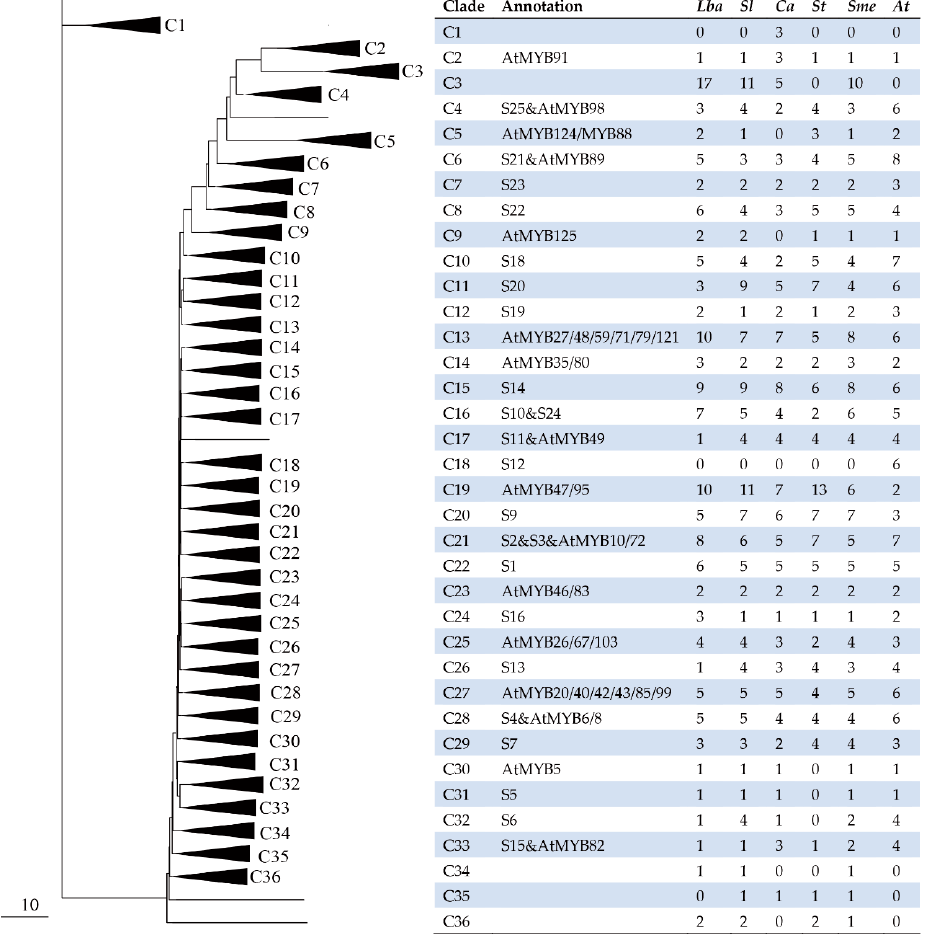
Figure 2. A phylogenetic tree of R2R3-MYB proteins. A total of 137 proteins from wolfberry ( Lba ), 133 from tomato ( Sl ), 108 from pepper ( Ca ), 109 from potato ( St ), 123 from eggplant ( Sme ), and 124 from Arabidopsis (At) were used. The full-length amino acid sequences of R2R3-MYB proteins were aligned using Muscle and the phylogenetic tree was constructed using the maximum-likelihood method. R2R3-MYB proteins from the six species clustered into 36 subgroups (triangles) desig- nated as C1 to C36. Four proteins did not fit well into subgroups (lines). The tables on the right indicate the number of subgroup members in each species. The uncompressed tree is available in Supplementary Figure